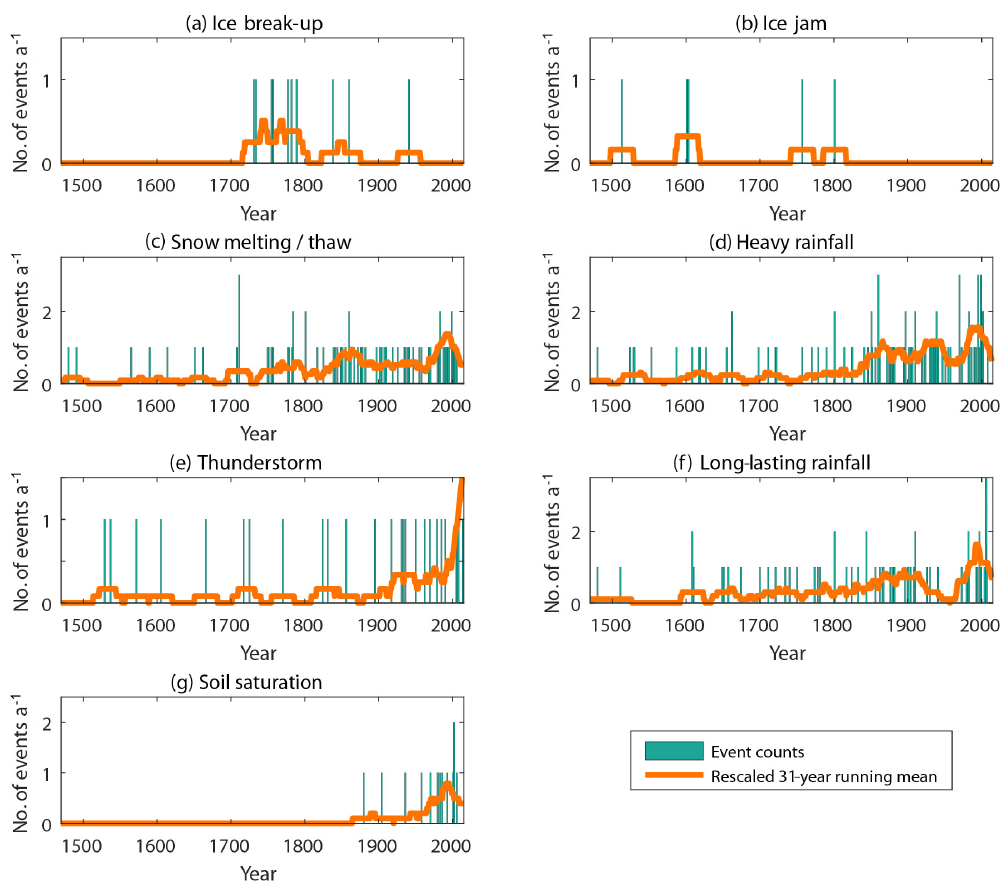
Figure 14. Chronologies of events according to their causes. Events for which several causes are documented (Fig. 7a) appear in the different corresponding